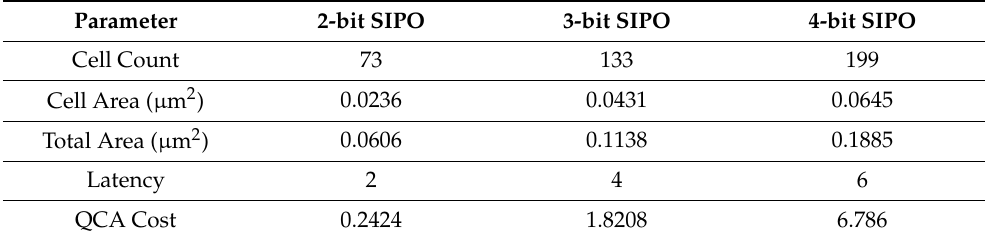
Table 2. Performance parameters of SIPO shift